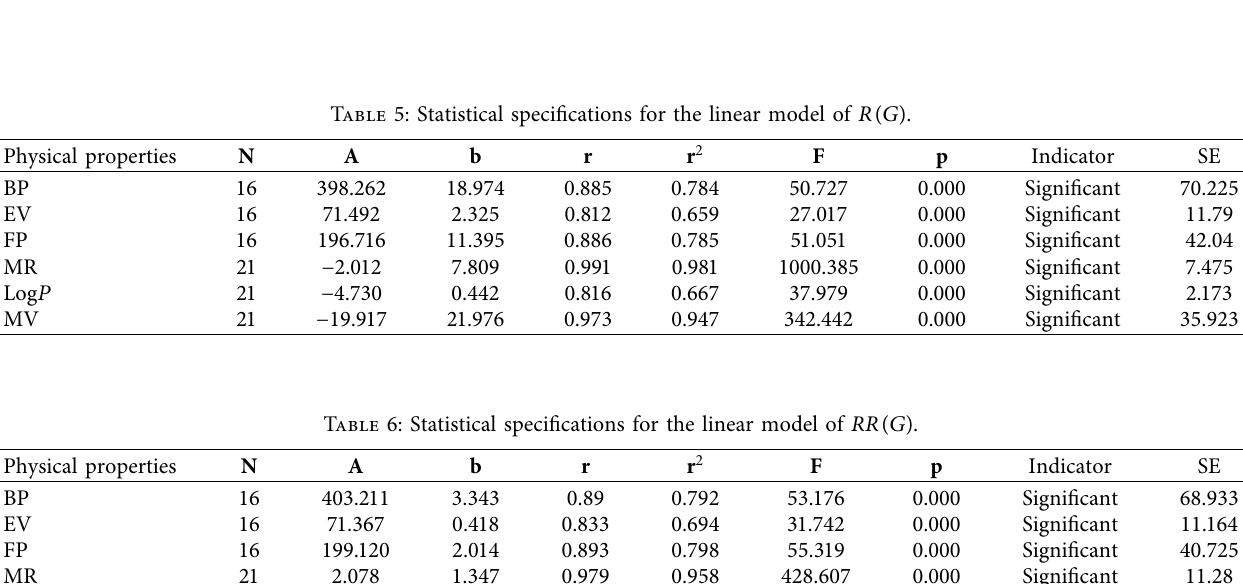
Table 4: Statistical specifications for the linear model of M